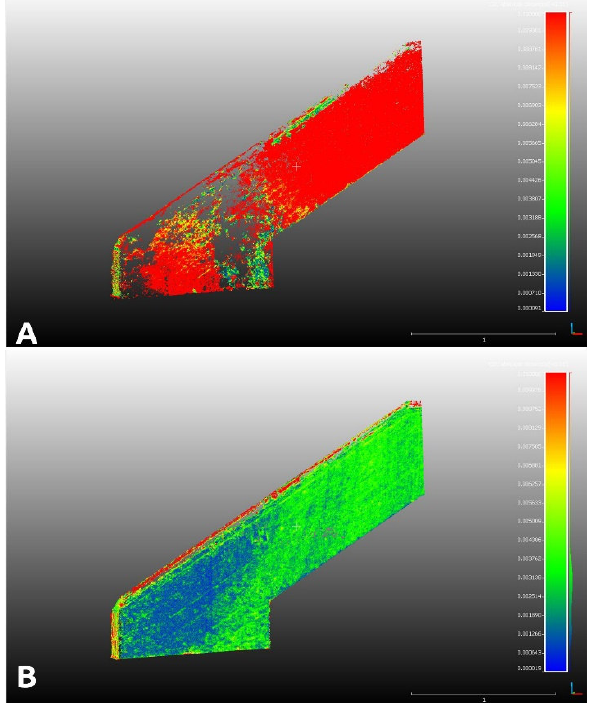
Figure 12. C2C distances analysis performed in CloudCompare with LiDAR data set as ground truth. Max distance set at 0.01 m. 360 configuration: automatic process with native Exif (A), process with modified Exif